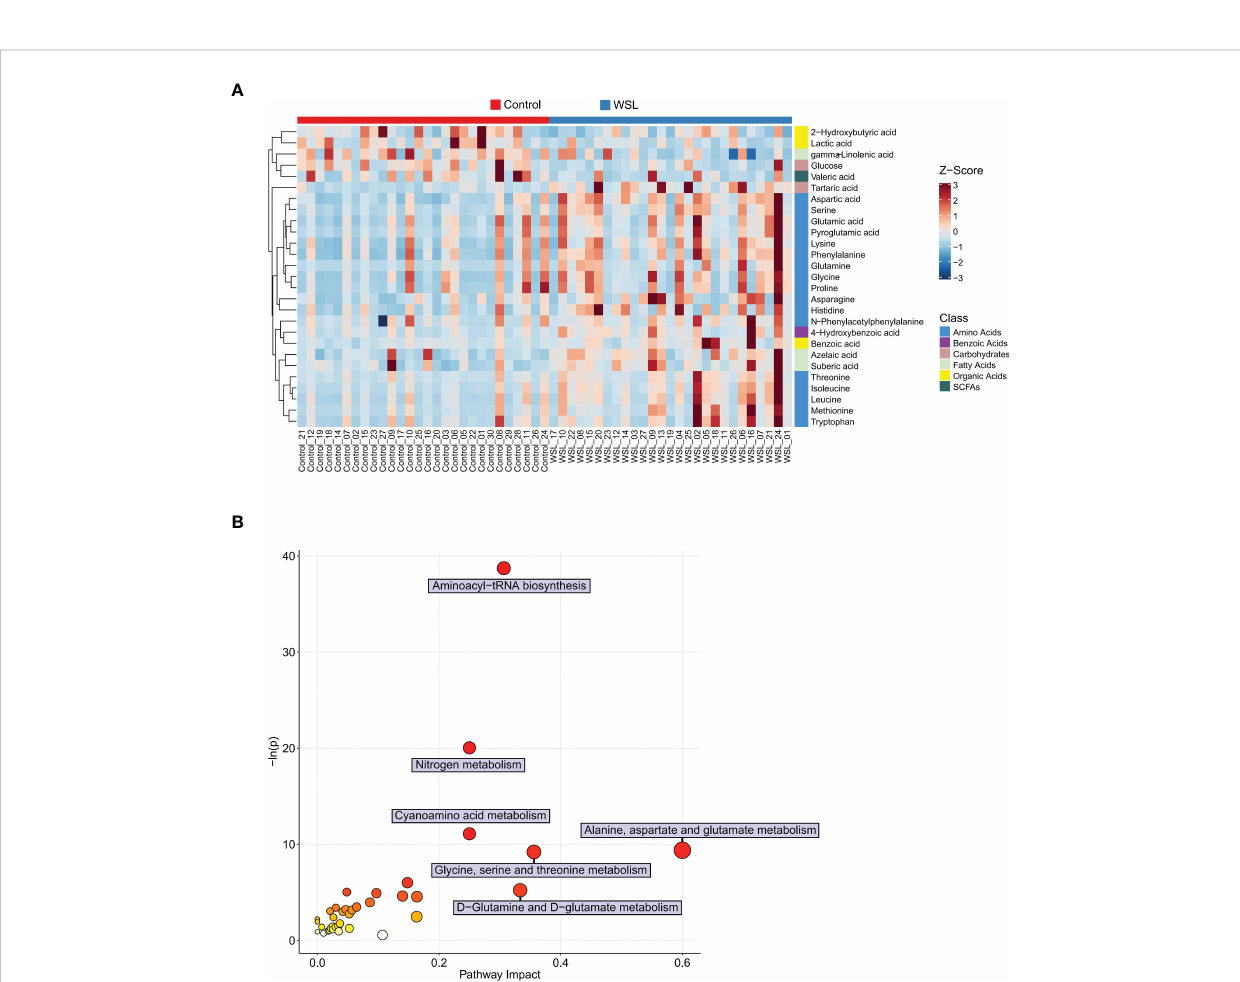
FIGURE 6 Potential biomarkers of the control and WSL groups. (A) Heatmap visualization of Z scores in each group. Each column represents an individual sample, and each row represents a metabolite. The color of each square represents the relative concentration of the corresponding metabolite of the sample, with red indicating a higher concentration and blue indicating a lower concentration (p < 0.05). (B) Bubble diagram of pathway enrichment analysis of differentially expressed metabolites. The color and size of each circle represent the p value (the redder the color, the smaller the p value) and the pathway impact value (the larger the size of the point, the higher the impact score), respectively. Pathways were considered signi fi cantly enriched if p < 0.05 and impact >